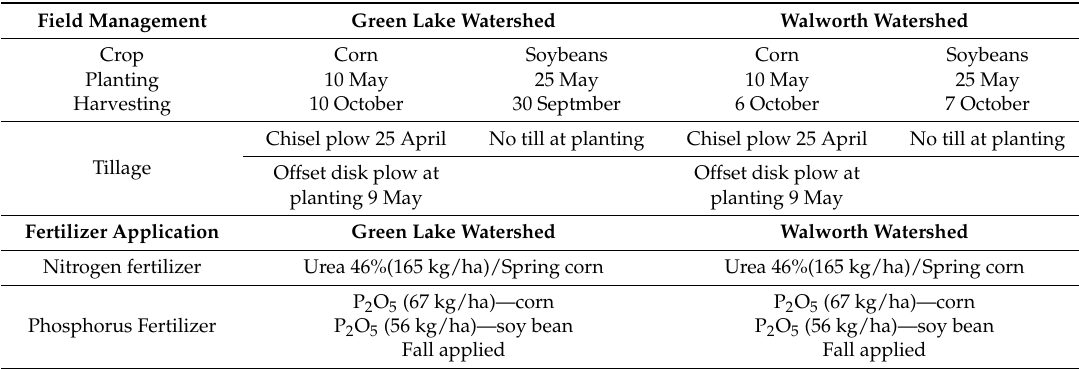
Table 1. Cropland management in the Green Lake watershed and Walworth watershed. Includes dates of planting and harvesting, types of tillage, and the application of